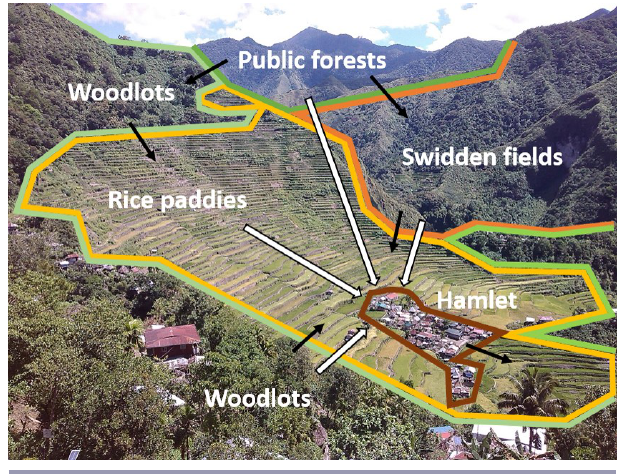
Fig. 1 . The Ifugao land use system. The rice paddies receive water-carried nutrients from ecosystems located above (black arrows). Woodlots are located around the rice terraces and hamlet, whereas public forests are located further away on the surrounding mountains. Swidden fields are cultivated on slopes too steep to make terraces. Harvested products are transferred to the hamlet (white arrows). The terrace shape of the rice paddies allows for the optimal use of nutrients and minimal erosion despite the steep slope (modified from Margraf and Voggesberger 1984; picture taken in Batad by the lead author [ACC] in